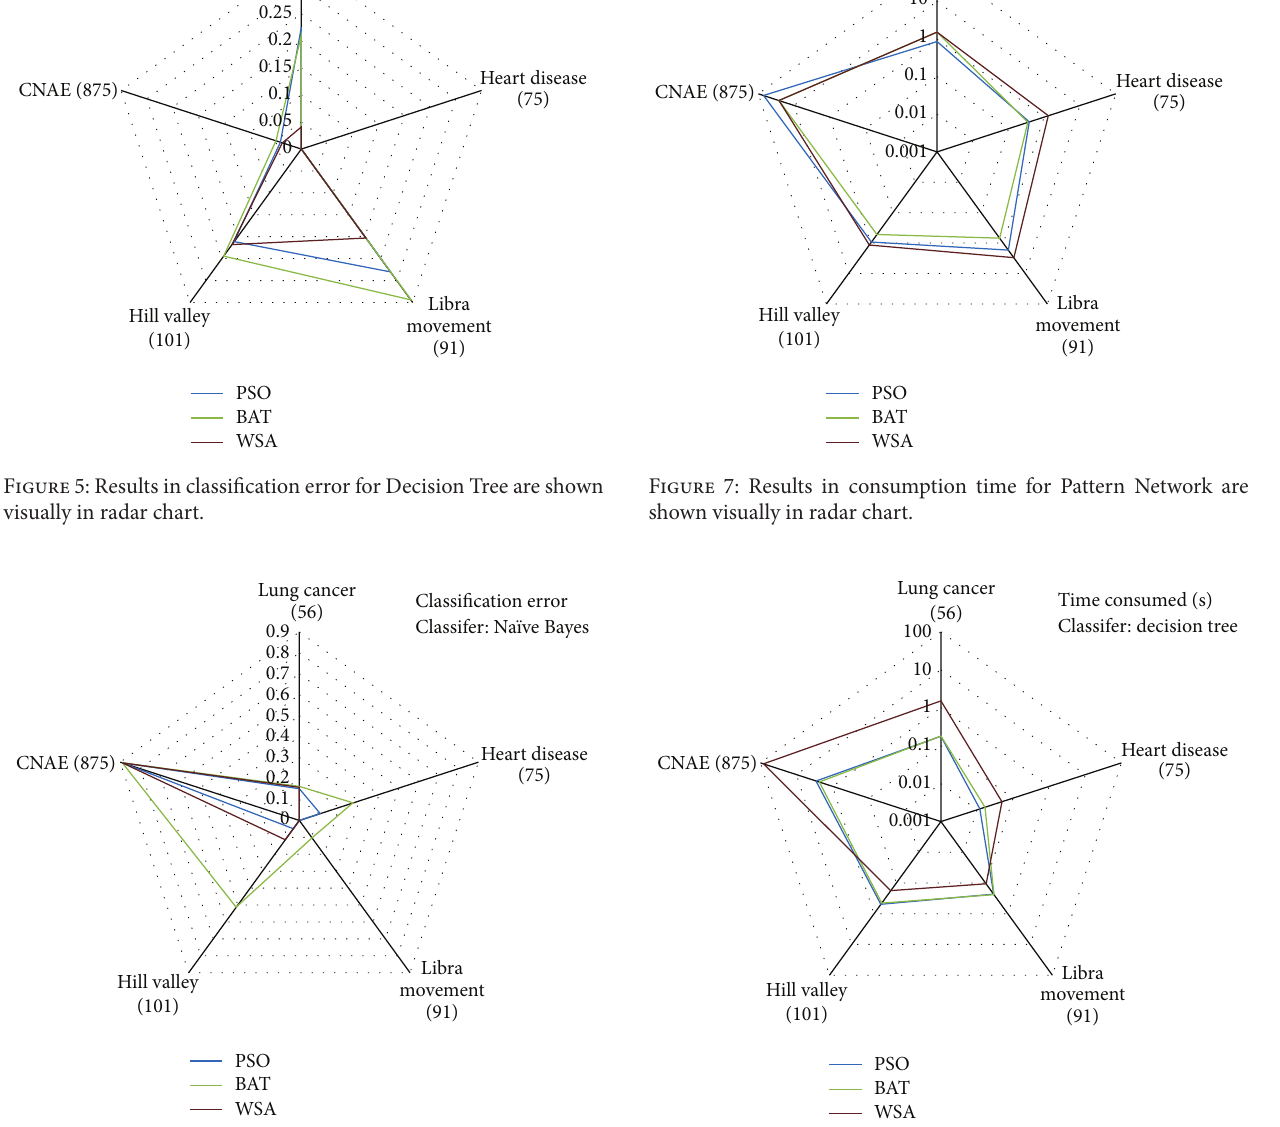
Figure 6: Results in classification error for Na¨ıve Bayes are shown visually in radar chart.